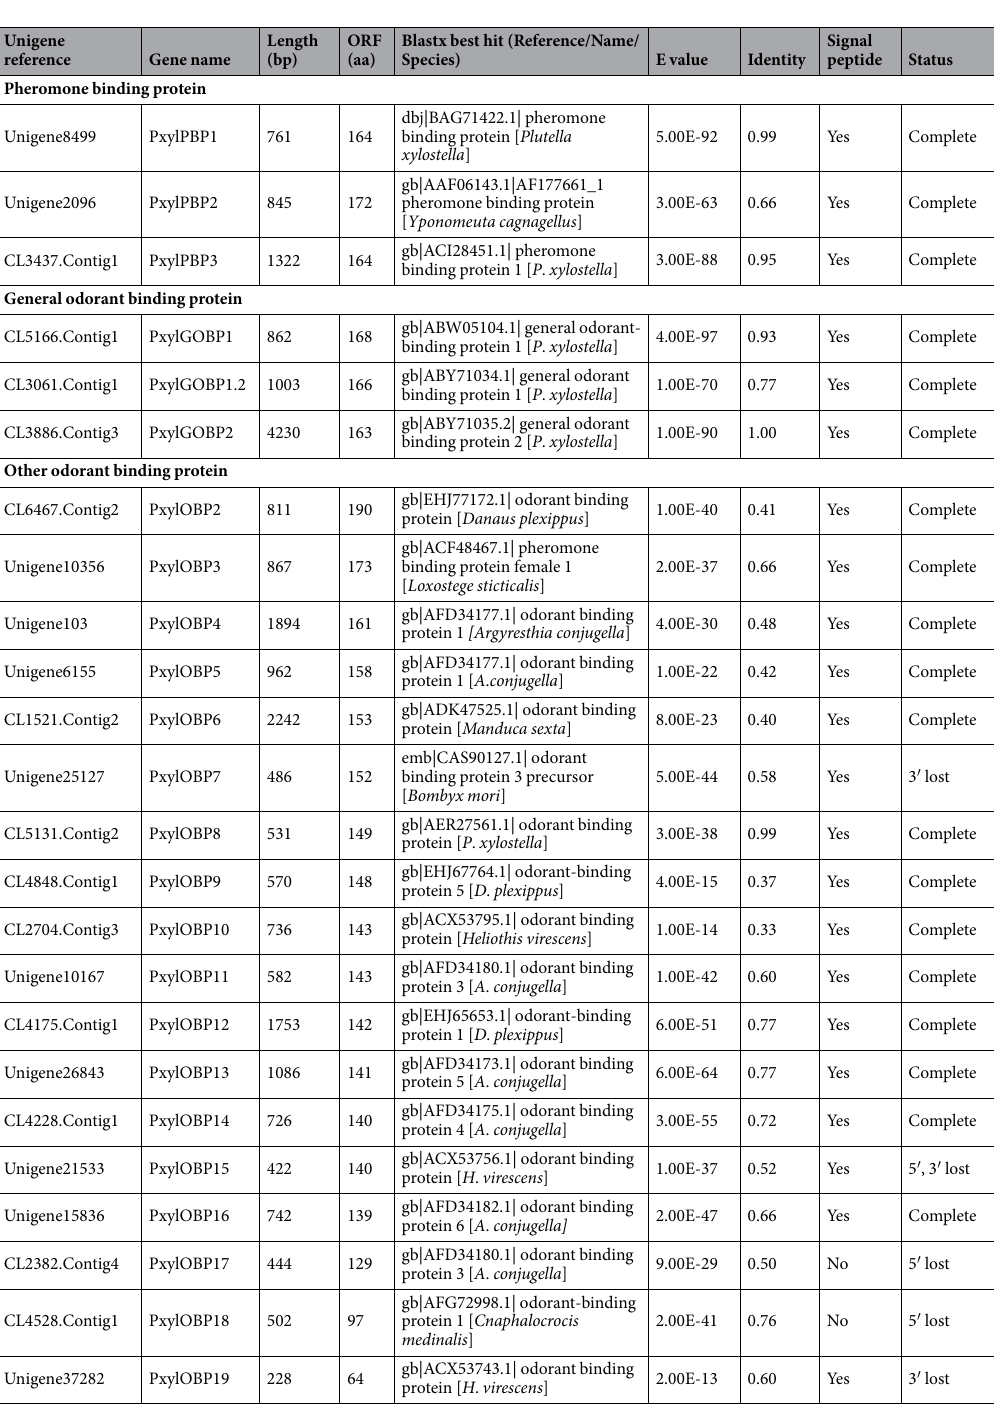
Table 4. Candidate odorant binding protein